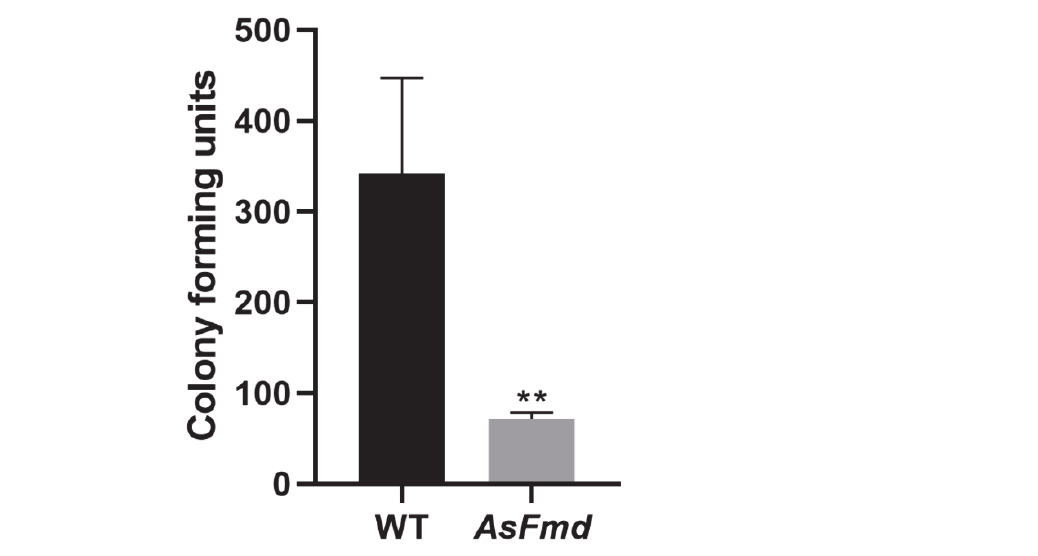
Figure 4. P. lutzii WT and AsFmd survival after macrophage infection. Following to recovering of ex vivo infection in murine J774 macrophages, CFU was counted at 7 days growth after the period of incubation. Shapiro–Wilk test was employed to determine data normality ( p values > 0.2). Student’s t -test was performed on experimental triplicate from biological replicate data in order to understand the magnitude of existent differences between the CFU of the two groups. ** repre- sents p values ≤ 0.005. Error bars represent standard deviation of two experimental replicates from biological